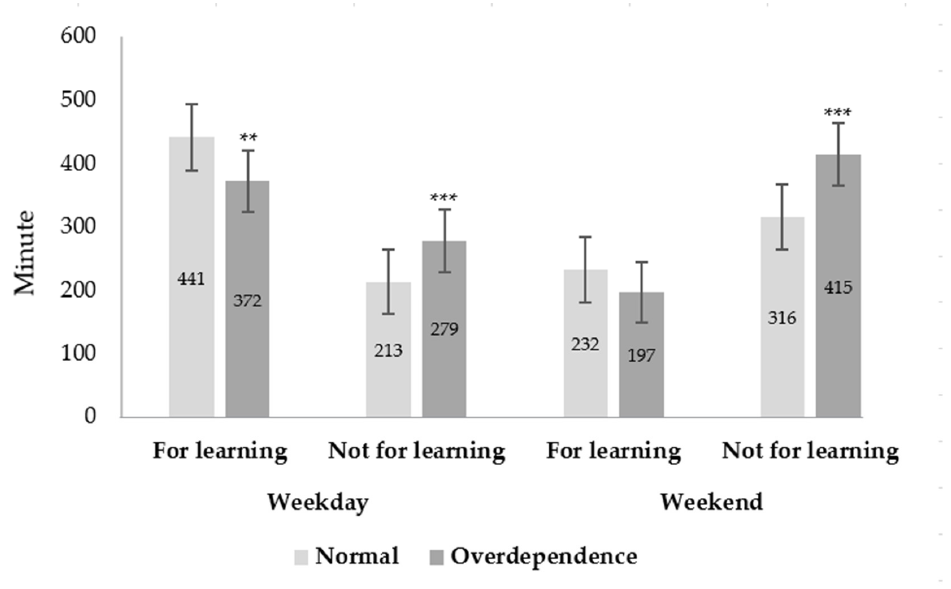
Figure 2. Mean of sedentary behavior time (minute per week). The significant differences between the two groups. *** p < 0.001, ** p < 0.01, Error bars represent the 95% confidence interval. There was a significant interaction effect between groups and sitting purposes, F(3, 1920) = 14.87, MSE = 51,579.75, p < 0.001, partial η 2 = 0.02.